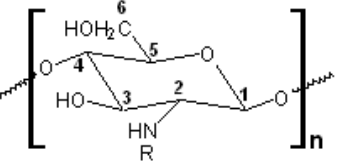
Figure 12. The structure of the model β (1 → 4)-tetramer.